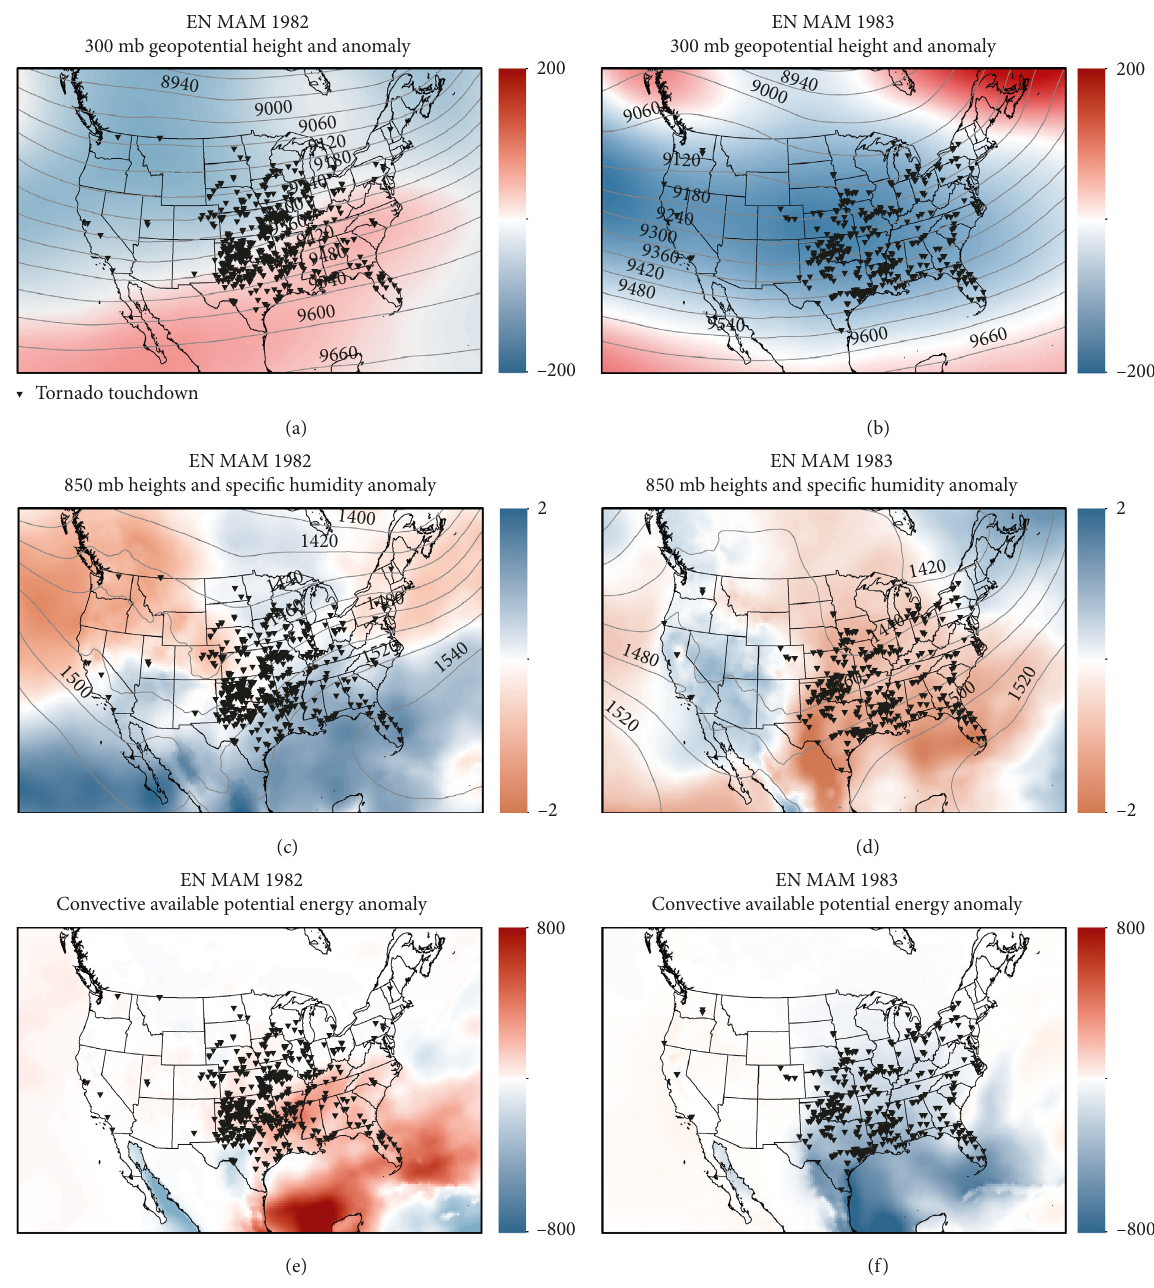
Figure 6: (a, b) 300mb geopotential heights (contours (m)) and anomalies (color (m)), (c, d) 850 mb geopotential heights (contours (m)) and specific humidity anomalies (color (g